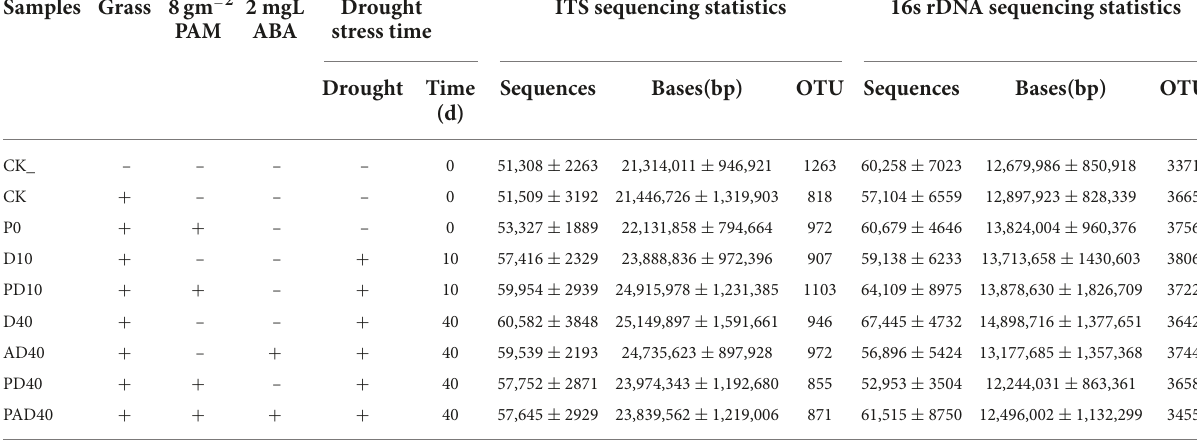
TABLE 1 Preparing methods and sequencing statistics of different soil samples. Samples Grass 8gm −